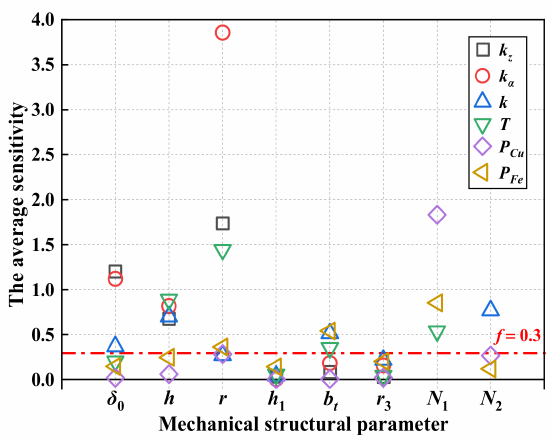
Figure 5. Sensitivity of different structural parameters to specified optimized performance.